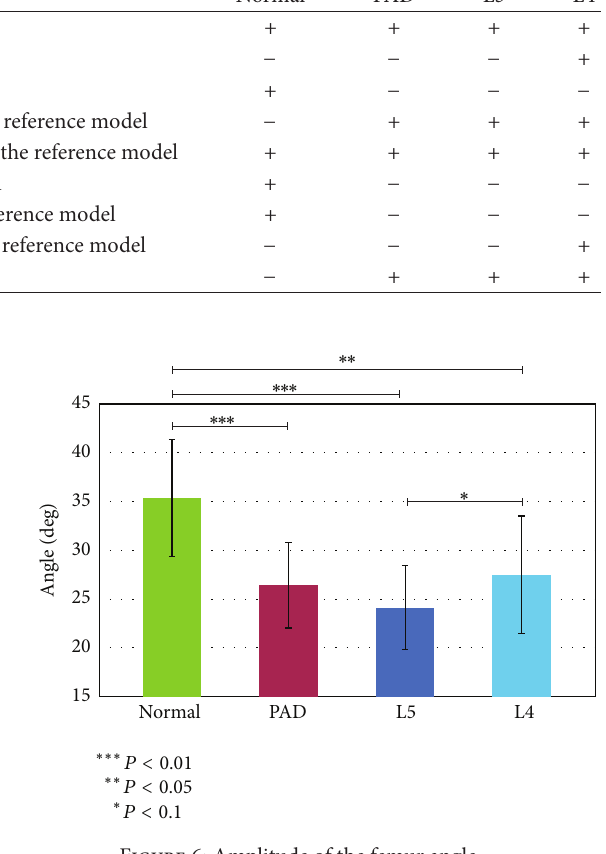
Figure 6: Amplitude of the femur